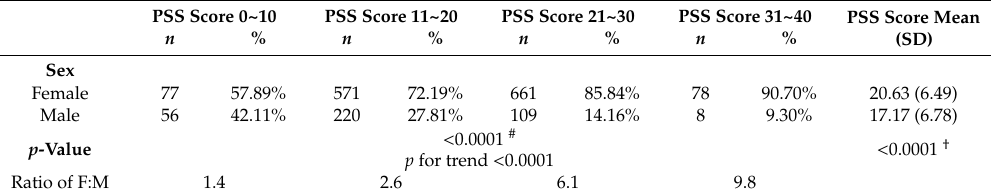
Table 2. Perceived stress scores by sex.